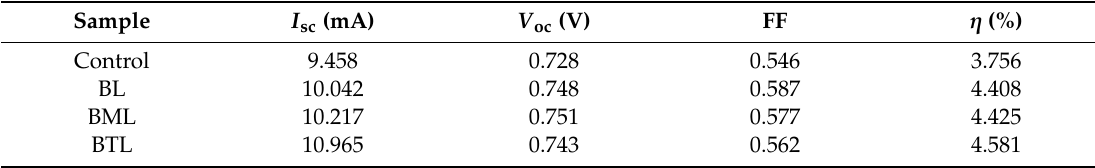
Table 2. Photovoltaic parameters of the DSSC integrated without (control sample) and with nanocrystalline TiO 2 layer. FF—fill